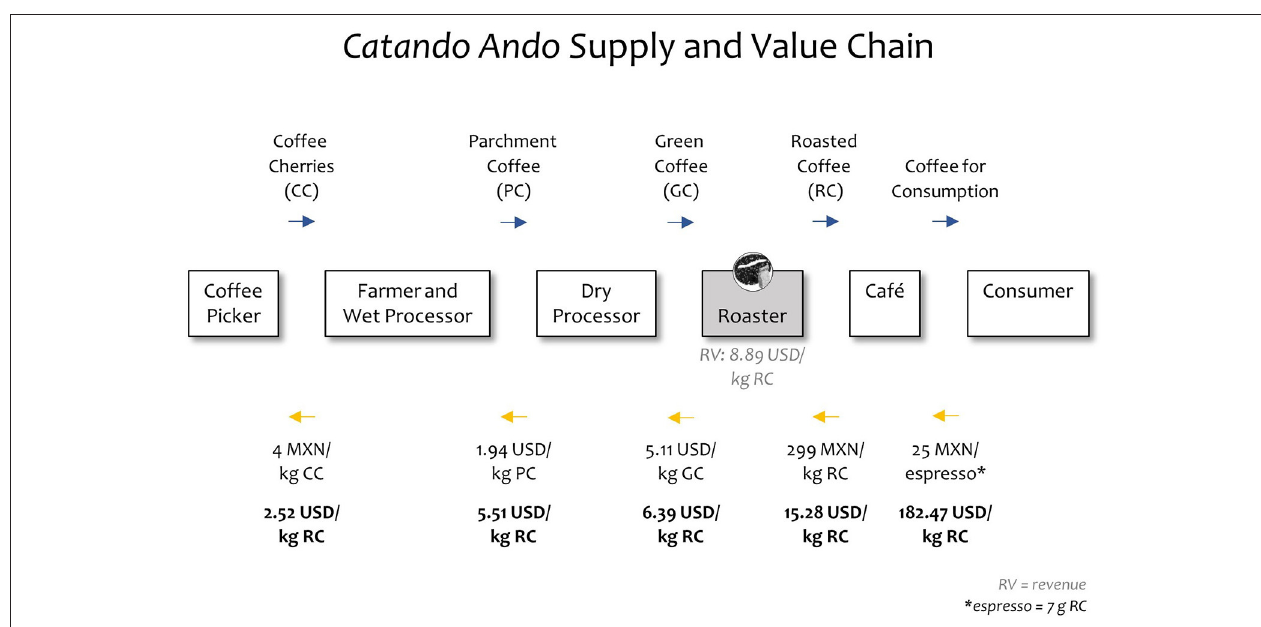
FIGURE 2 | Prior supply and value chain of Catando